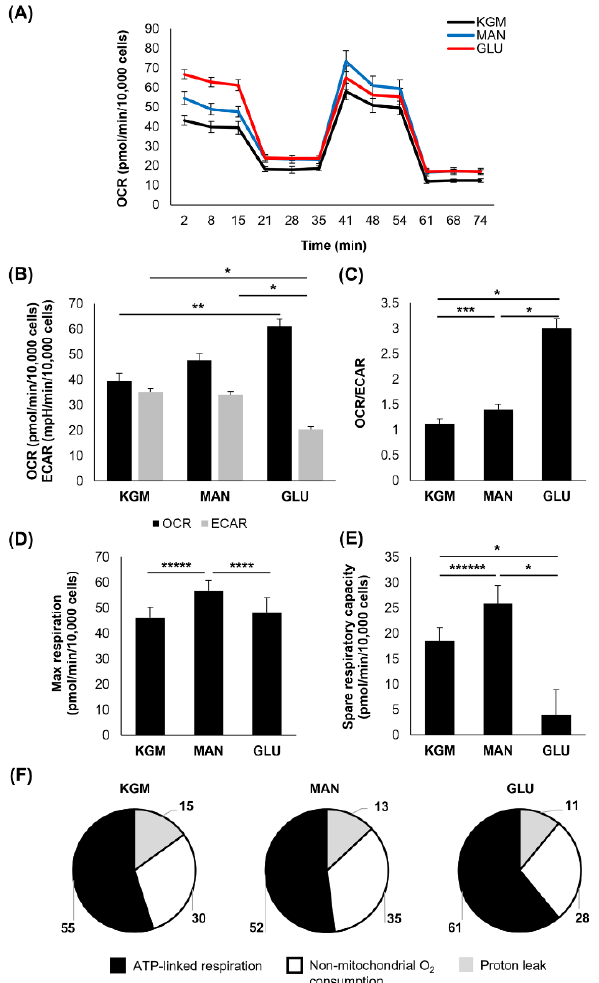
Figure 4. Hyperglycemia, not osmotic stress, shifted cells toward a respiratory phenotype after 9 days of culture. ( A ) OCR plotted as a function of time for both test and control groups. ( B ) OCR was increased in high glucose compared to KGM (** p < 0.05), whereas ECAR was decreased in high glucose compared to KGM and mannitol (* p < 0.001). ( C ) The OCR/ECAR ratio shifted toward a more respiratory phenotype for cells cultured in high glucose (* p < 0.001) and mannitol (*** p < 0.003). ( D ) Maximal respiration was increased in mannitol-treated cells compared to KGM (**** p = 0.004) and glucose (***** p = 0.007). ( E ) Spare respiratory capacity was reduced only in high-glucose-treated cells (* p < 0.001, ****** p = 0.003). ( F ) The proportion of oxygen consumption due to ATP-linked respiration, non-mitochondrial oxygen consumption, and the proton leak in the KGM control compared to glucose- and mannitol-treated cells. Bar graphs are presented as mean ± standard deviation. Pie charts are presented as percentage of total oxygen consumption. Graphs are representative of one experiment that was repeated three independent times. One-way ANOVA on ranks with Tukey post hoc comparison test (OCR and non-mitochondrial oxygen consumption) and one-way ANOVA with SNK multiple comparison test for all